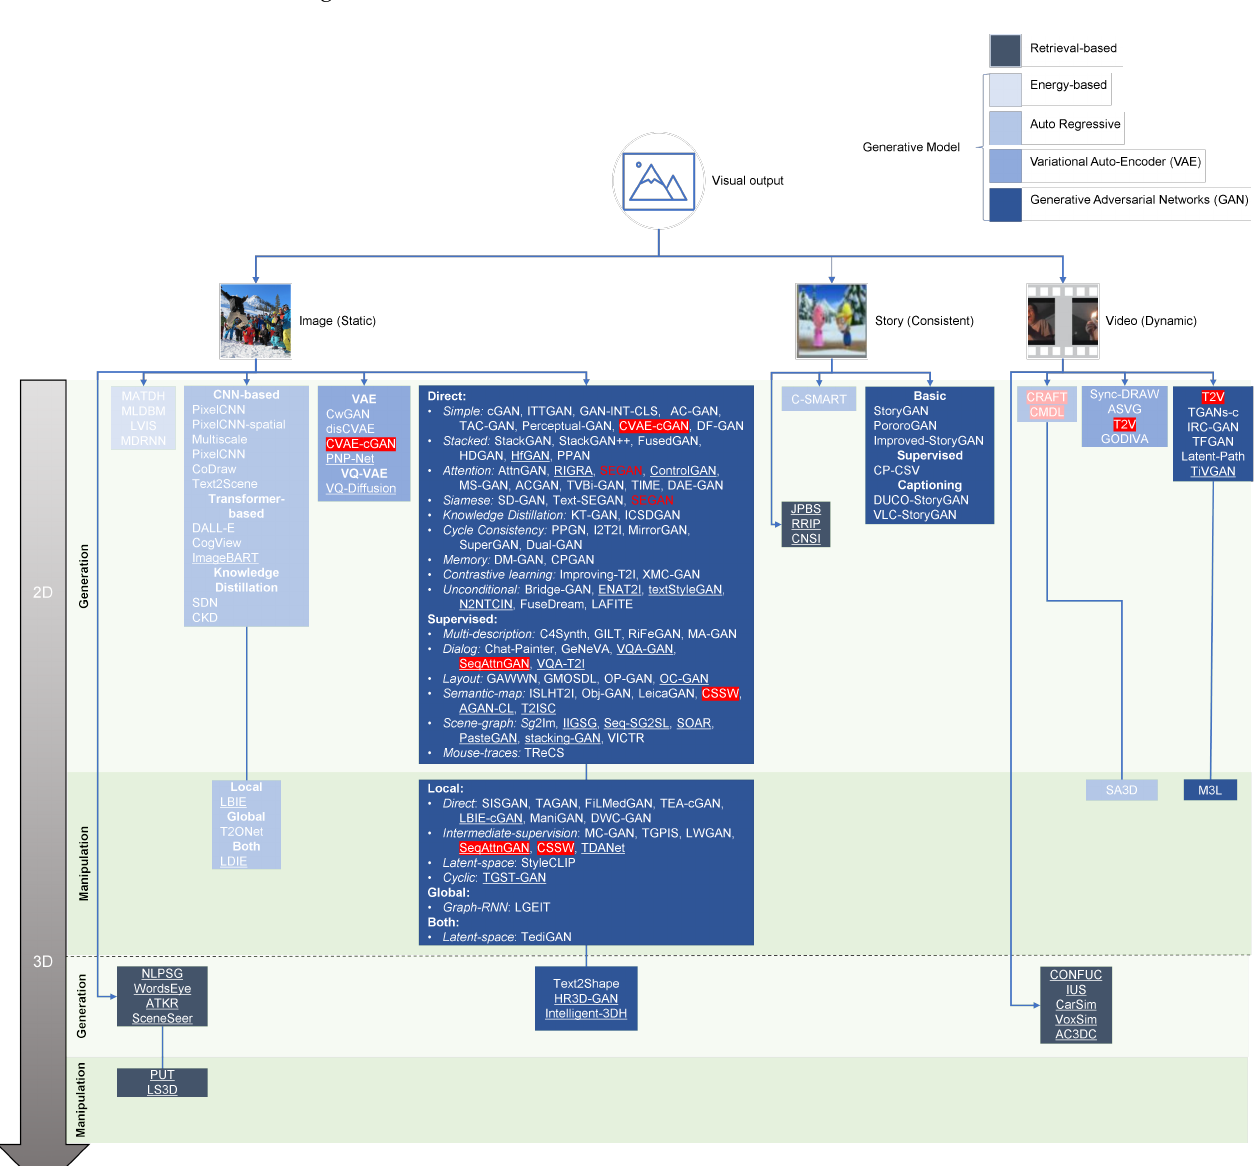
Figure 8. Taxonomy of Text-to-Visual output, where dark red markings indicate repetitions and light ones indicate the exceptional cases mentioned in the text. The papers listed in gray boxes are shown for the sake of completion and are not discussed in the